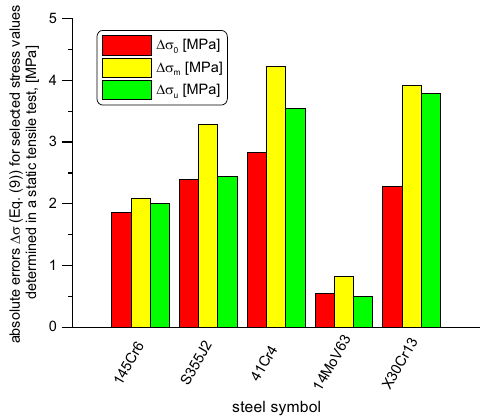
Figure 10: Comparison of the relative errors δσ for selected stress values determined in the static tensile test using equations ( 9 ) and ( 5 ) .